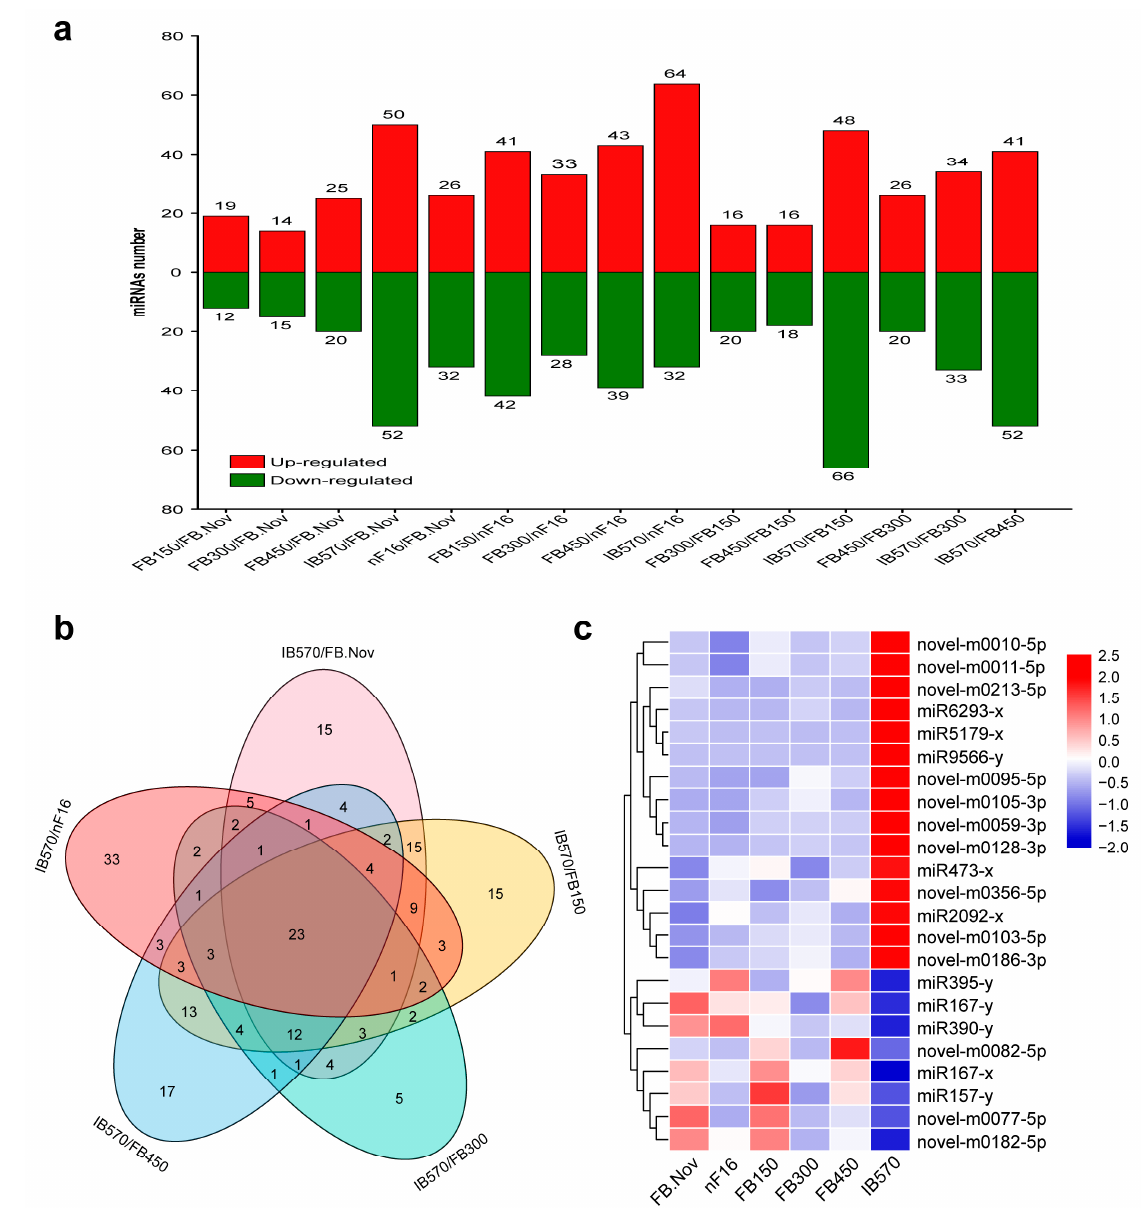
(Table S8), indicating that novel-m0186-3p and novel-m0077-5p could respond to a chilling environment and have opposite roles in regulating the dormancy of wintersweet floral buds.